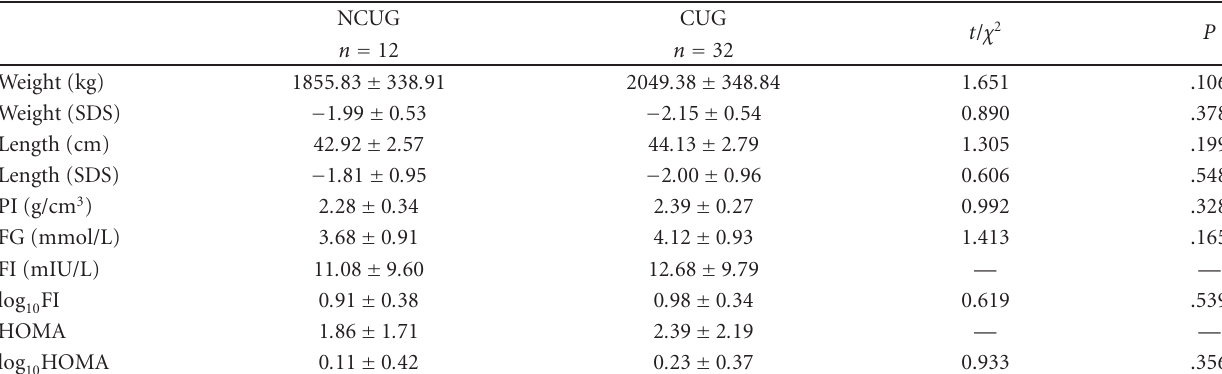
Table 2: Comparisons of birth size and shape and metabolic characteristics at 3 days of life between NCUG and CUG